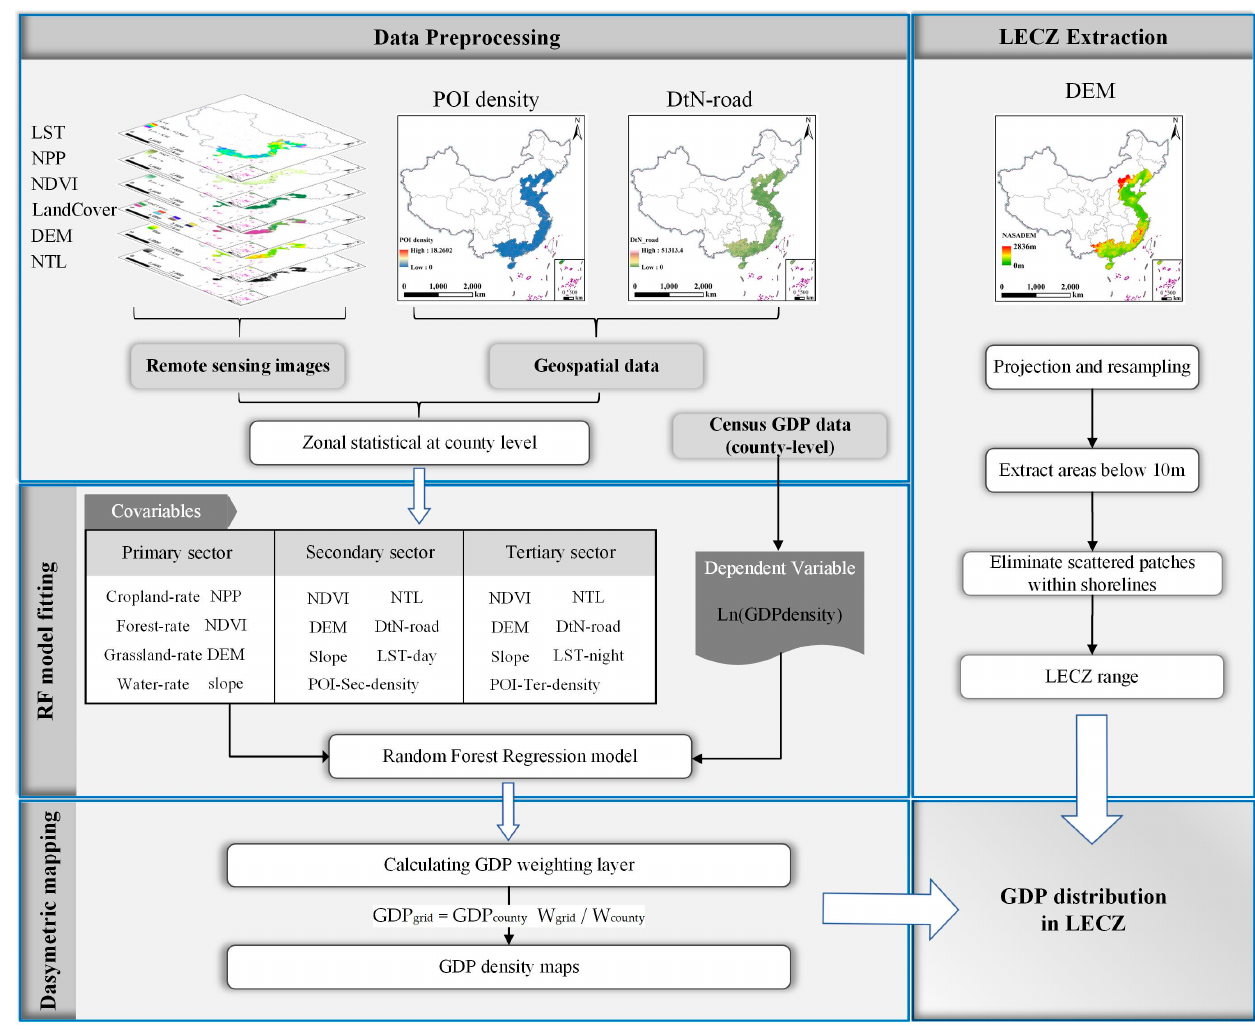
Figure 2. Flow diagram for producing the GDP maps of LECZ in China.